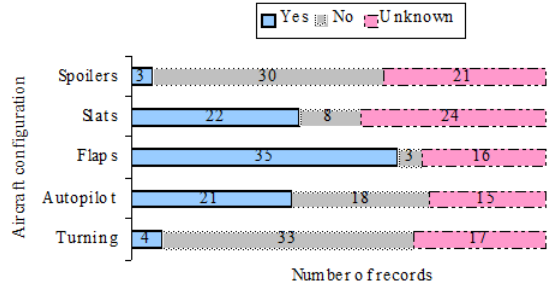
Figure 5. Distribution of records according to aircraft configuration parameter Table 2. Rounding up the average values